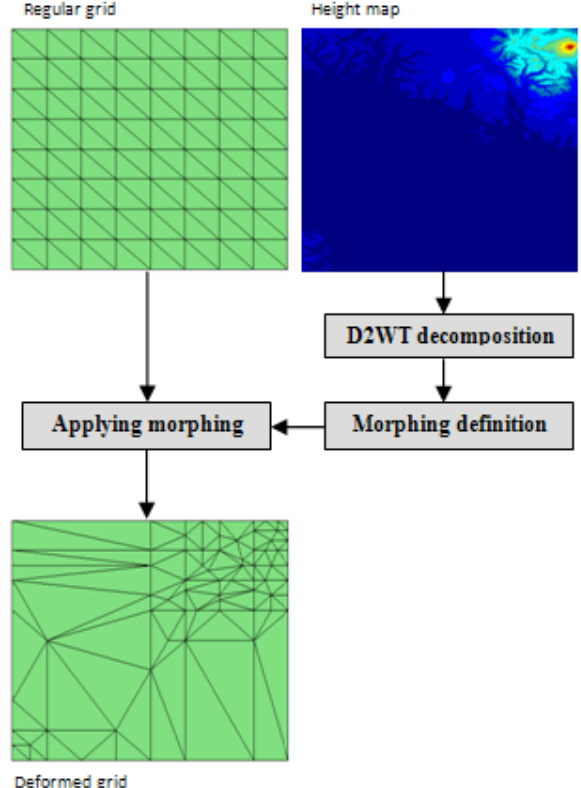
Figure 5. Illustration of the proposed morphing